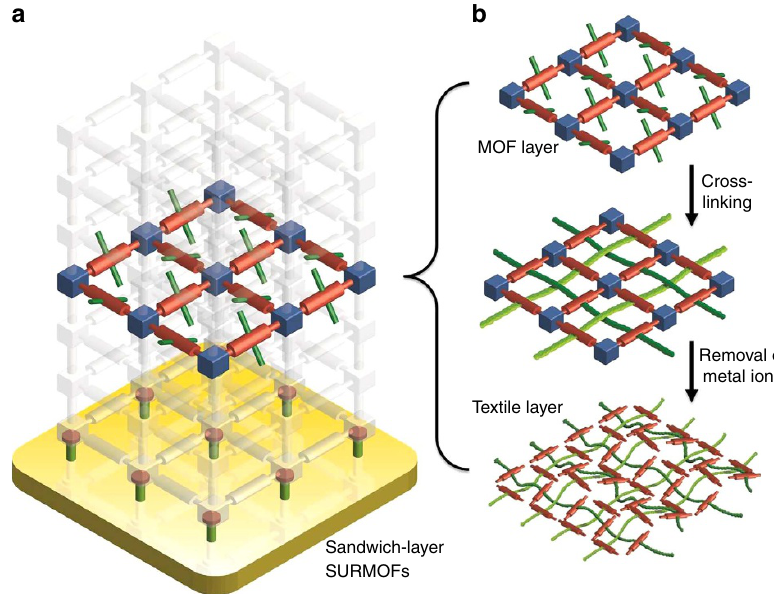
Figure 1 | Strategy for the formation of molecular textile. Schematic illustration of the heteroepitaxial sandwich-layer surface-mounted MOF (SURMOF) system ( a ) and the formation procedure of molecular weaving in the active MOF layer embedded between two sacrificial layers ( b